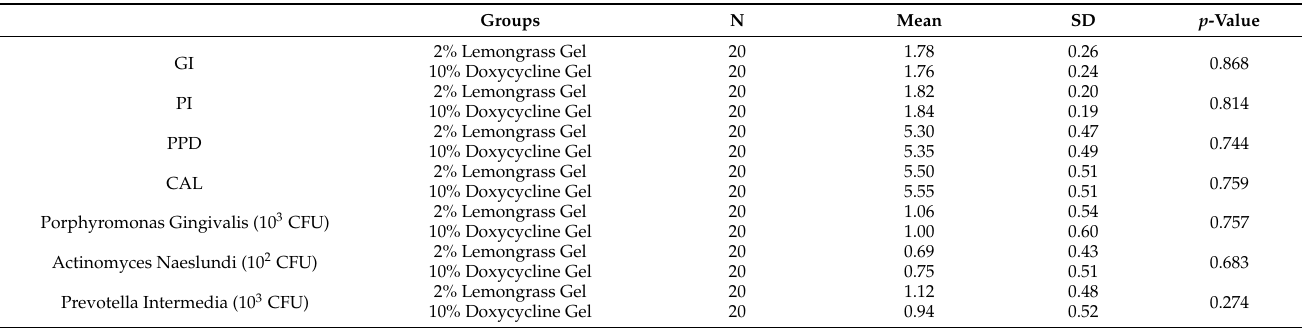
Table 2. Comparison of mean clinical parameters scores within groups at baseline, 1 month, and 3 month follow-ups.